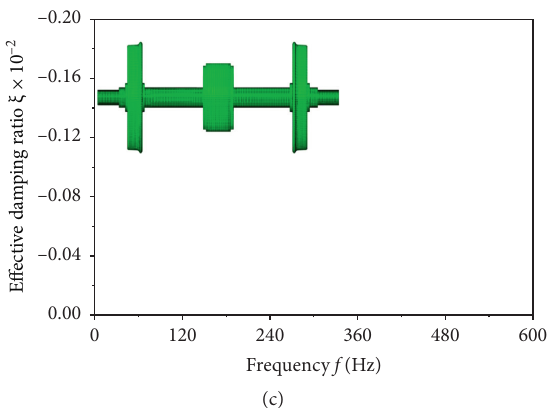
Figure 7: Frequency distributions of frictional self-excited vibration of the power wheelset-track system in different gearbox mounting positions: (a) original mounting position, (b) 1/2 L mounting position, (c) symmetrical mounting